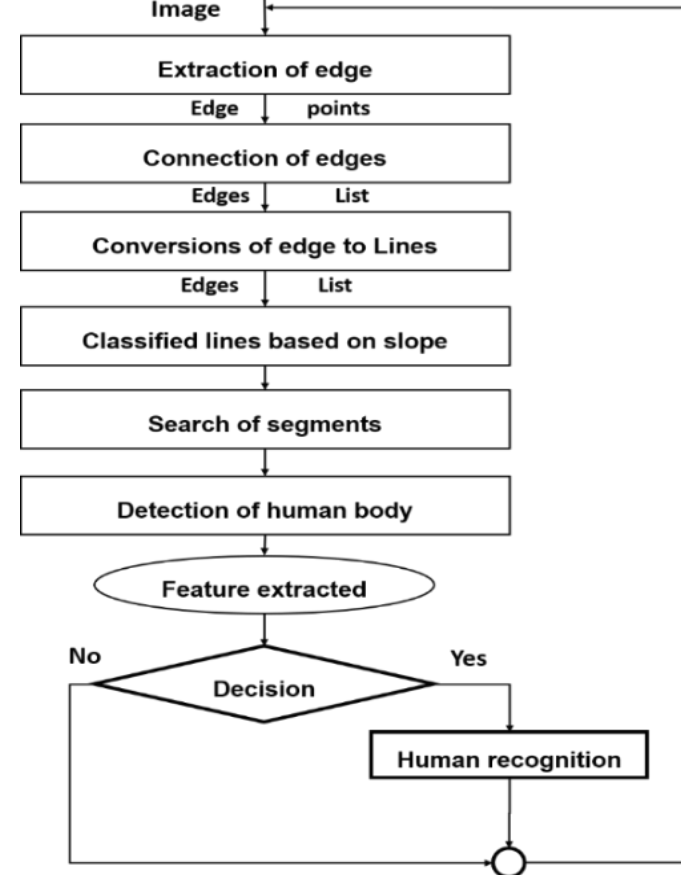
Figure 5. Gait recognition processes.